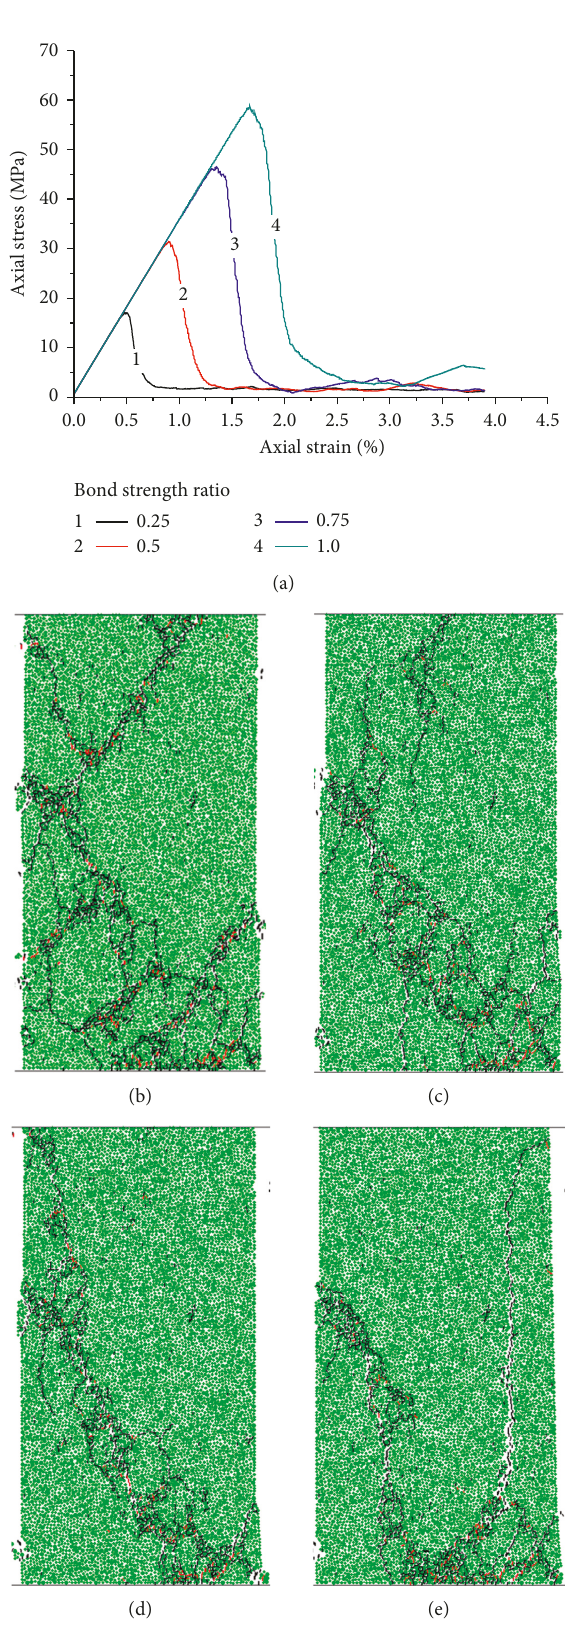
Figure 2: Strength and failure mode for specimen with different bond strength ratios: (a) the stress-strain curve. Failure mode for bond strength ratio is (b) 0.25, (c) 0.50, (d) 0.75, and (e) 1.0.